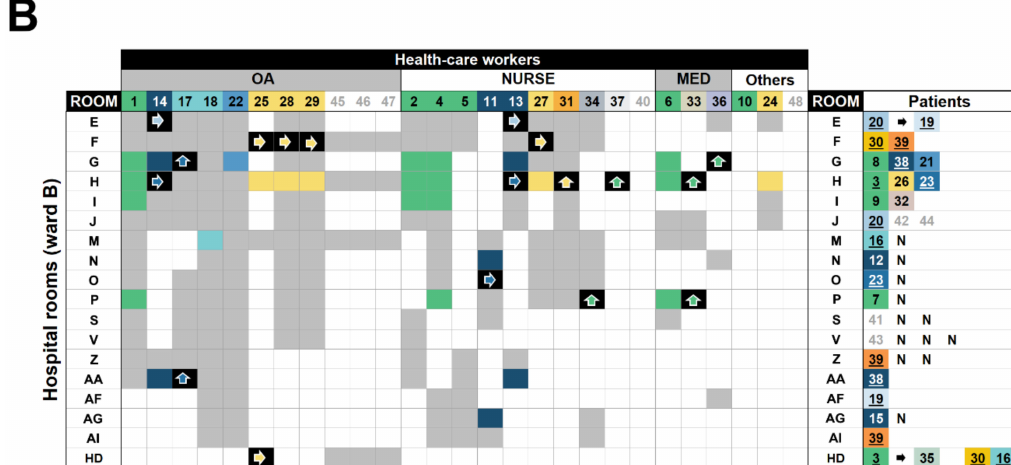
Figure 2. Combined genomic and epidemiological investigation of a SARS-CoV-2 nosocomial outbreak. ( A ) Maximum likelihood phylogenetic tree of SARS-CoV-2 genome sequences analyzed during the investigation of SARS-CoV-2 positive cases detected in a hospital ward in August 2020, Portugal. The tree includes viral consensus sequences obtained from 22 out of the 27 infected health-care workers (HCWs) and 17 out of 21 infected patients (colored nodes). To provide better phyloge- netic context, the two closest sequences of the outbreak SARS-CoV-2 variant detected in Portugal (Portugal/PT1550/2020, collected in 21 June 2020, and Portugal/PT1614/2020, collected on 8 July 2020; https://insaflu.insa.pt/covid19/; as of 9 November 2020) and the SARS-CoV-2 reference genome sequence (used as root; Wuhan-Hu-1/2019; MN908947.3) were also included. Bar graphs next to the tree depict the within-patient frequency fluctuation of three SNP phylogenetic markers (also highlighted in the respective branch) that were detected either as minor variants (<50% in frequency) or as (nearly-)fixed variants in viral populations collected from distinct infected individuals (bars are colored according to the phylogenetic placement of the respective SARS-CoV-2 consensus sequences). The SNP profile of the outbreak-related SARS- CoV-2 is provided in Supplementary Table S2. ( B ) HCW-patient contacts occurring during the 15-day period before the large screening. HCW and patient codes are colored according to the phylogenetic placement of the respective SARS-CoV-2 consensus sequences (panel A), with exception of those without SARS-CoV-2 genome data (gray numbers in white fields). The “contact tracing matrix” summarizes the visits of infected HCWs to patient’s rooms (more details about the timeline of the visits is provided in Figure S1) (colored fields). Fields are colored according to virus sequence similarity between HCW and patients, as follows: (i) if a given HCW visited a room with a patient with the identical viral consensus sequence (i.e., same genetic profile), the field is colored according to the genetic profile (as in panel A) (high likelihood of direct transmission); (ii) if the contact involved ascendent/descendent genetic profiles (plausible transmission) and there was no other contact with an individual with an identical virus genetic profile, the field is colored in black with a colored arrow indicating the potential direction of transmission; (iii) if the contact HCW-patient is not supported by viral genetic evidence (implausible transmission), the fields are colored in gray. HD, hemodialysis. N, patients testing negative for SARS-CoV-2; Underlined patient number means that the patient stayed in different rooms during the study